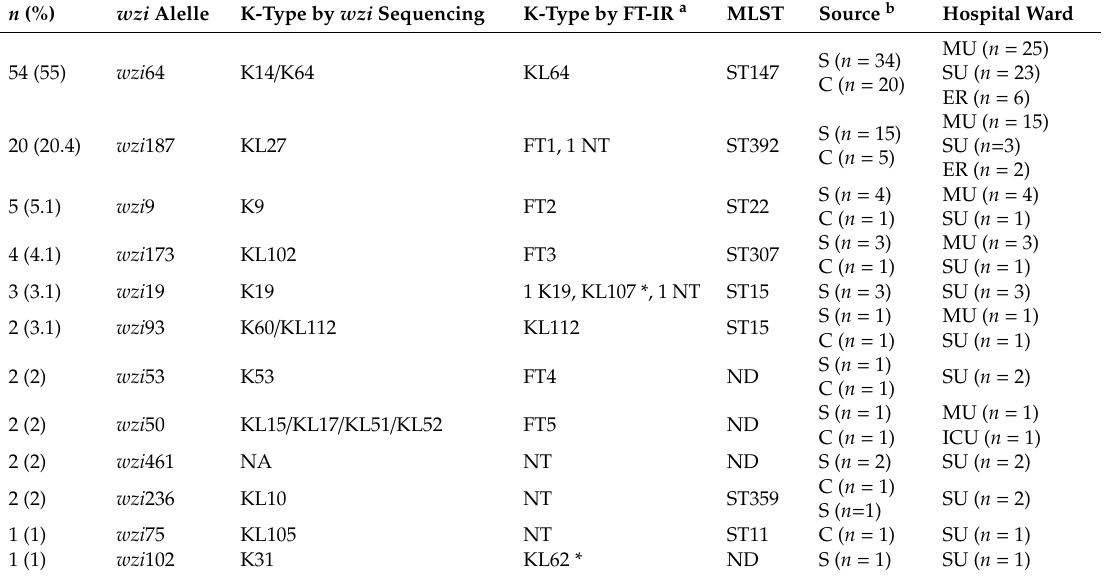
Table 3. Performance of Fourier Transform infrared (FT-IR) typing and epidemiological data